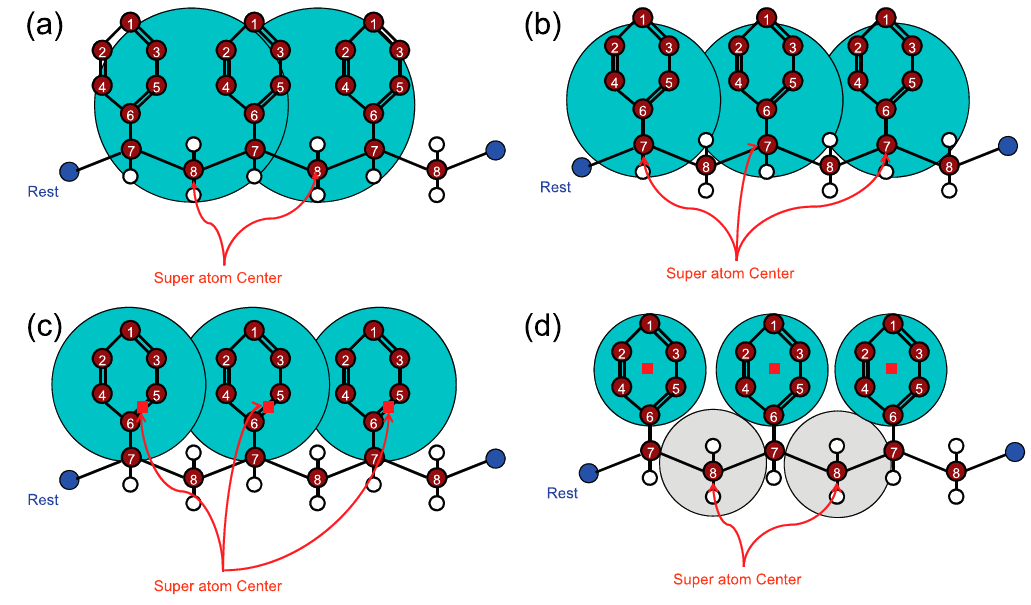
Figure 4. Different definitions for the super atoms of CG PS utilized by ( a ) Müller-Plathe and co-workers [347–349]; ( b ) Sun and Faller [351,352]; ( c ) Qian et al. [353]; and ( d ) Harmandaris et al. [354,355]. Reprinted from Li et al. [299] under the terms of the Creative Commons Attribution License.